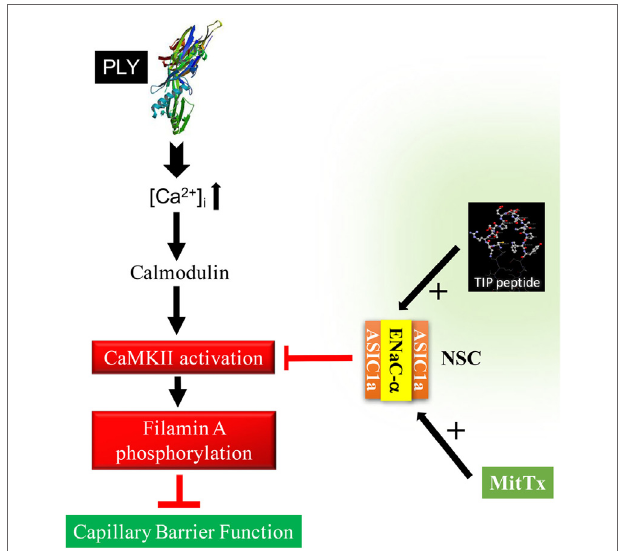
FigUre 7 | Proposed sequence of events in the role of epithelial sodium channel (ENaC)- α in barrier protection in pneumolysin (PLY)-treated human lung microvascular endothelial cells. PLY, upon pore formation, increases Ca 2 + -influx (3), which in turn mobilizes calmodulin. Calmodulin activates CaMKII, which in turn phosphorylates its substrate filamin A (FLN-A) (15). Phosphorylated FLN-A promotes stress fiber formation and increases capillary permeability. Activation of NSC, by either TIP peptide (binding to ENaC- α ) or MitTx [binding to acid-sensing ion channel 1a (ASIC1a)], abrogates PLY-mediated CaMKII activation and protects as such from PLY-induced